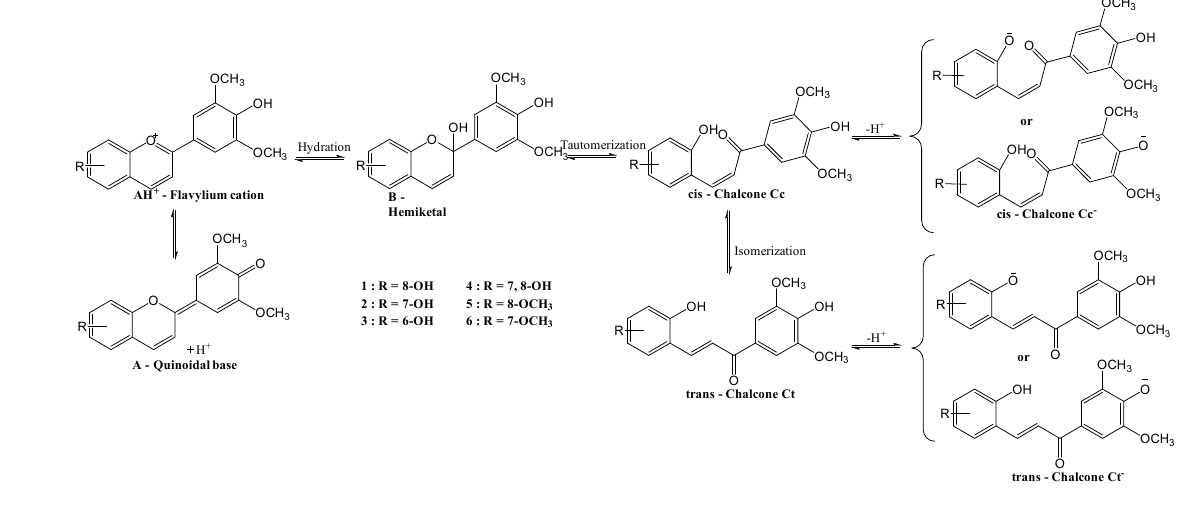
Table 6. Absorption wavelengths of the predominant species of the flavylium dye solutions at dif- ferent pH values.